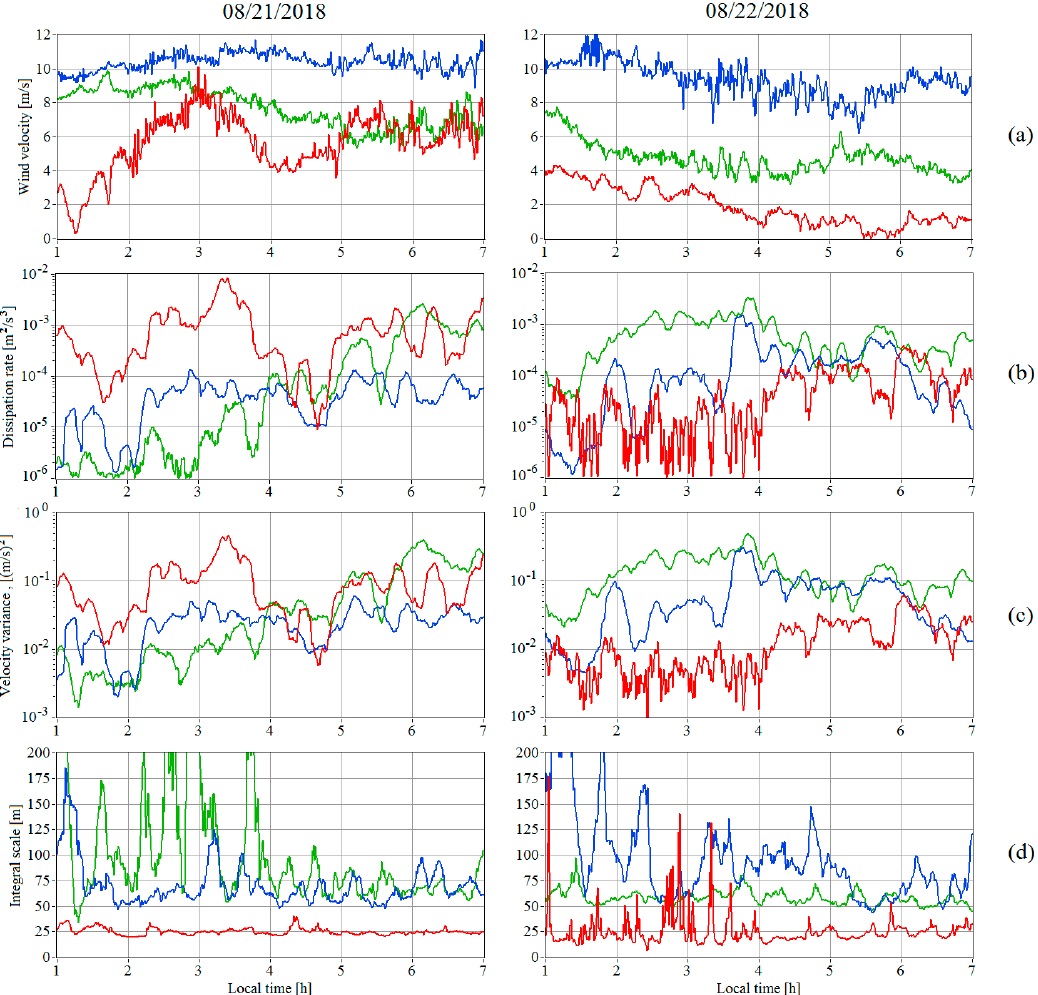
Figure 8. Time series of wind velocity ( a ), turbulent energy dissipation rate ( b ), variance of the radial velocity ( c ), and integral scale of turbulence ( d ) at heights of 117 (red curves), 351 (blue curves), and 507 m (green curves) during LLJs of 21 (left) and 22 (right) August 2018. The data are taken from Figure 7.